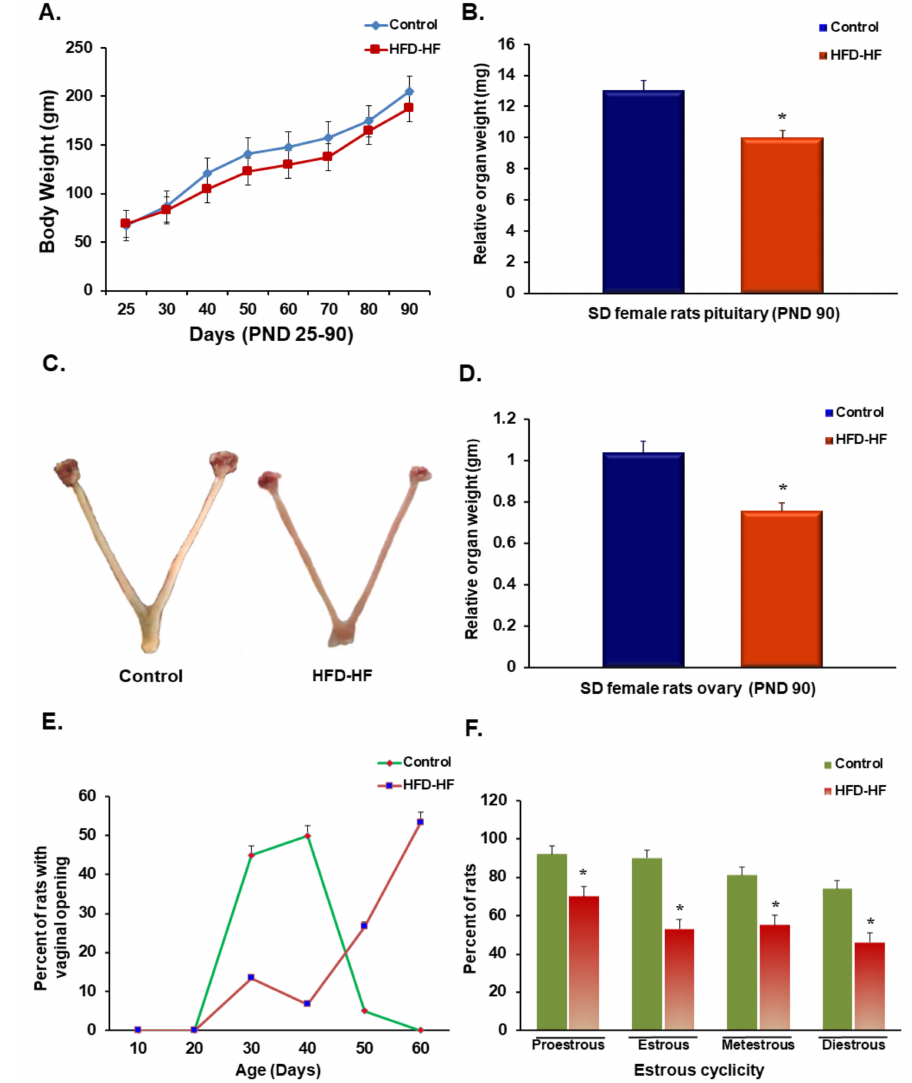
Figure 1. Effect of prepubertal exposure to HFD-HF diet on ( A ) body weight, ( B ) relative pituitary weight, ( D ) relative ovary weight of adult rats, ( E ) vaginal opening, and ( F ) estrous cyclicity. A representative picture ( C ) shows the ovary of the control and HFD-HF-fed rat. Each value is the mean ± SEM of six animals in each group. Bars with an asterisk (*) denote statistically significant differences between such means at p ≤ 0.05